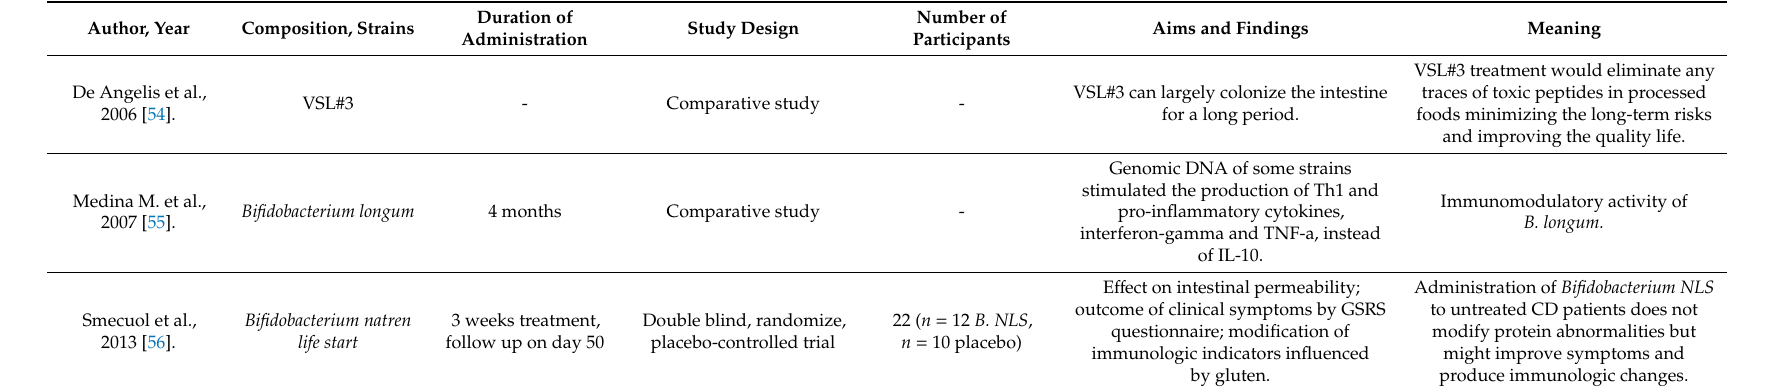
Table 2. Studies evaluating probiotic use in celiac disease